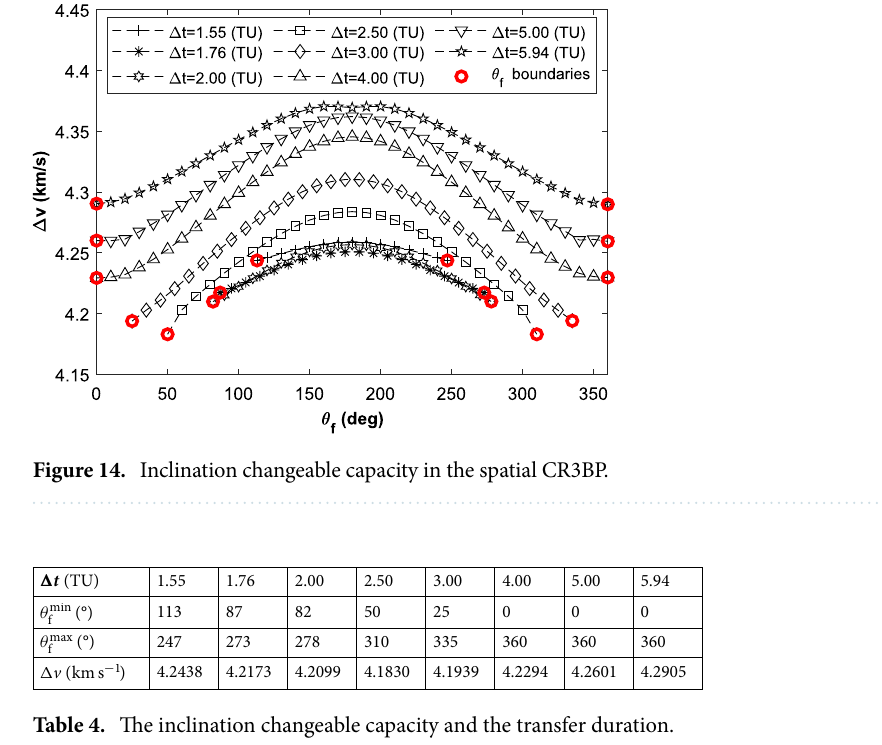
Table 4. The inclination changeable capacity and the transfer duration.